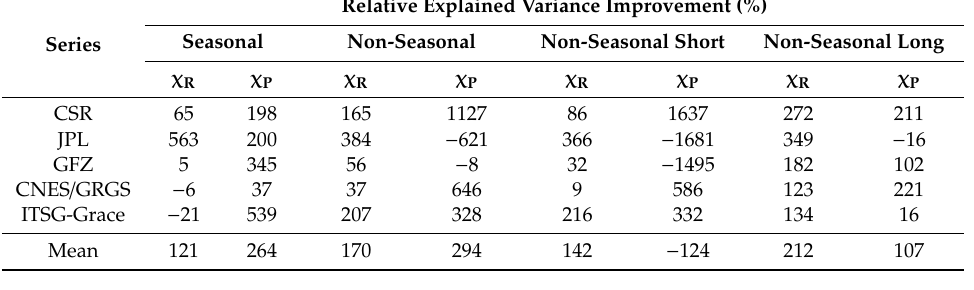
Table 4. The improvement in relative explained variance between HAM and GAO for new GRACE solutions compared with the older solutions (positive, increased relative explained variance; negative, decreased relative explained variance).